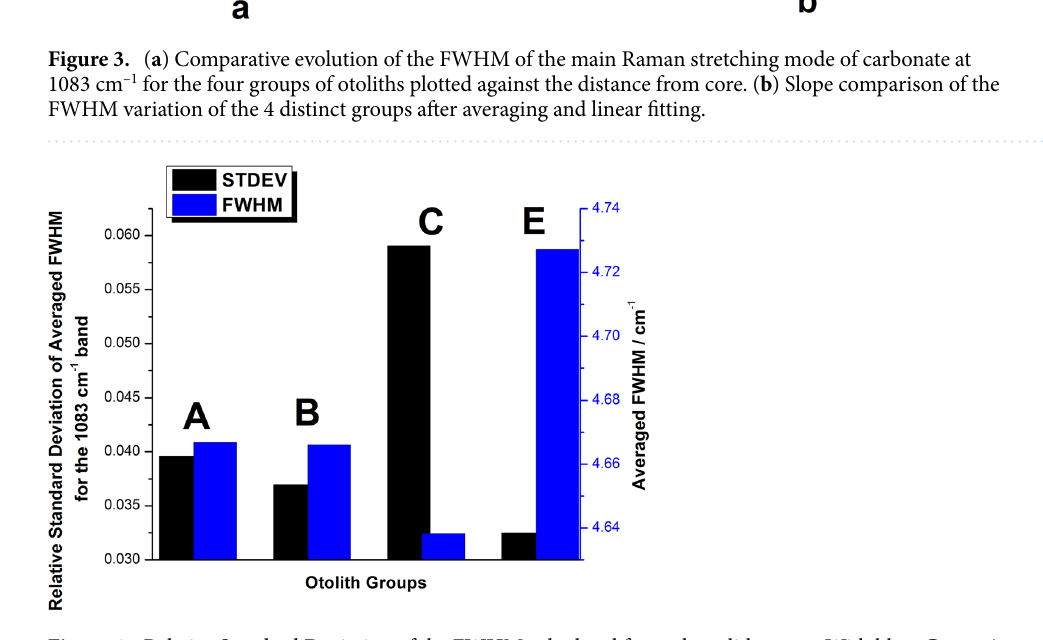
Figure 4. Relative Standard Deviation of the FWHM calculated for each otolith group. With blue, Group A, green Group B, red Group C and black Group